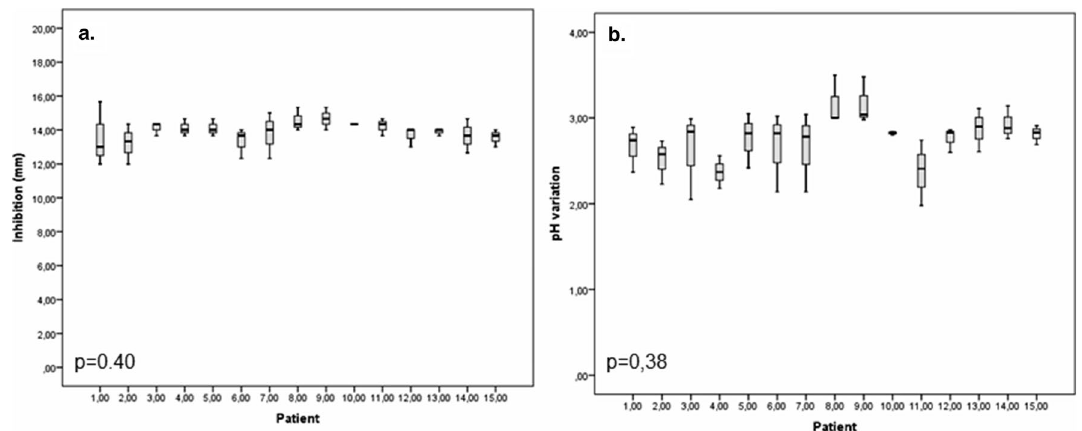
Figure 4. Inhibition ability and the pH reduction of mixed cultures of dental biofilm from carious lesions from 15 patients produced by the foods evaluated. ( a ) Inhibition median produced by product No. 14. ( b ) Median of pH decrease in the mixed culture generated by product No. 14. Kruskal–Wallis test *P < 0.05, **P <